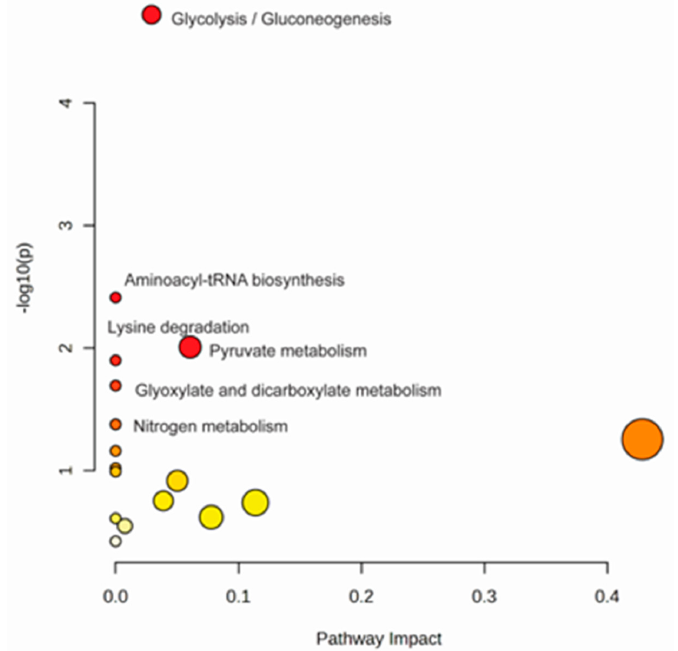
Figure 4. Metabolite pathways related to SARS-CoV-2 infection, considering the metabolites of VIP